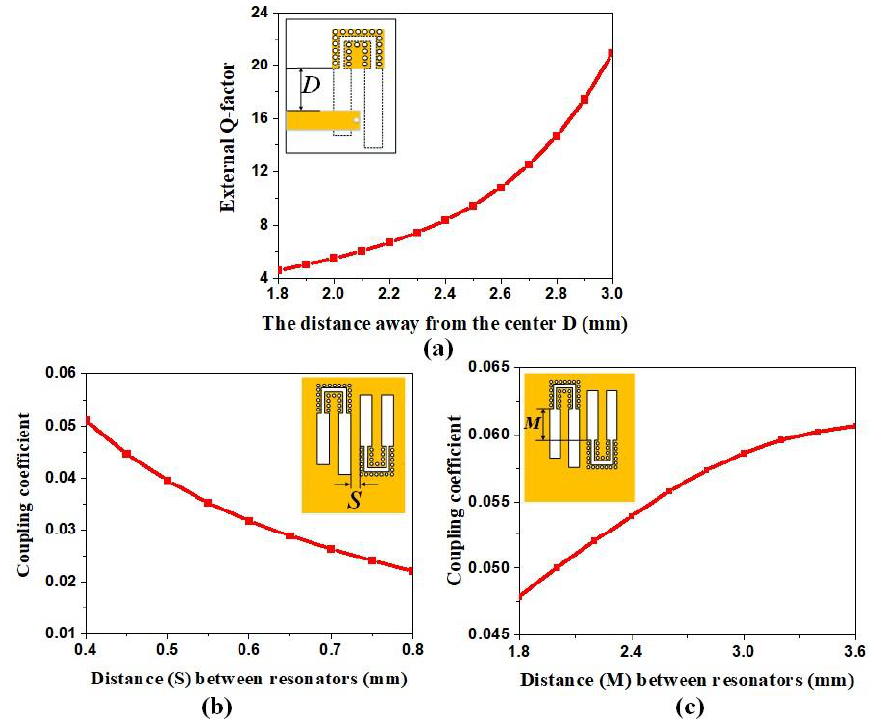
Figure 3. External Q-factor and coupling coefficients of the PWS filter.